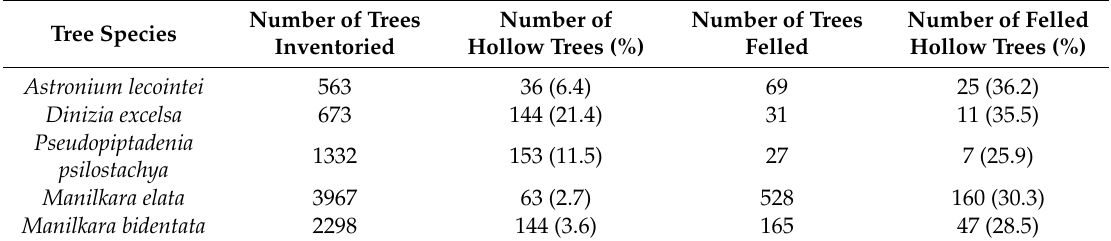
Table 1. Numbers of trees with stem hollows (cavities, hollow or rotten cores) detected during forest inventories, and the additional number of felled trees with hollows not detected by inventory crews. In parenthesis are the percentages of the total number of trees inventoried or felled for each species. Number of Trees Number of Number of Trees Number of Felled Tree Species Inventoried Hollow Trees (%) Felled Hollow Trees (%) Astronium lecointei 563 Dinizia excelsa 673 Pseudopiptadenia 1332 psilostachya Manilkara